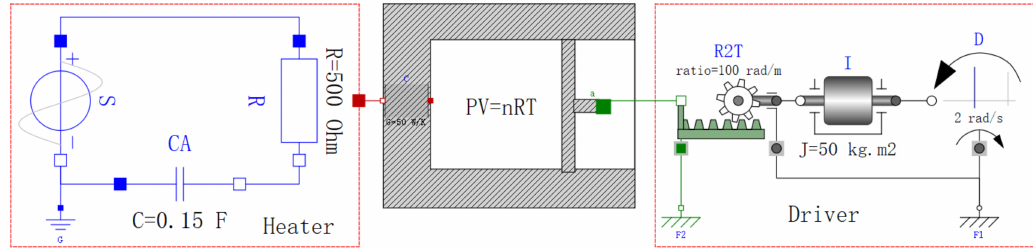
Figure 9. Example system to illustrate the hierarchical structural analysis of DAE models.